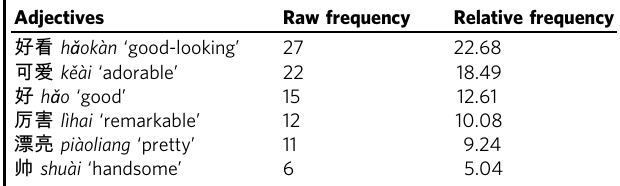
Table 9 Most frequent adjectives in girls ’ normal speech style.